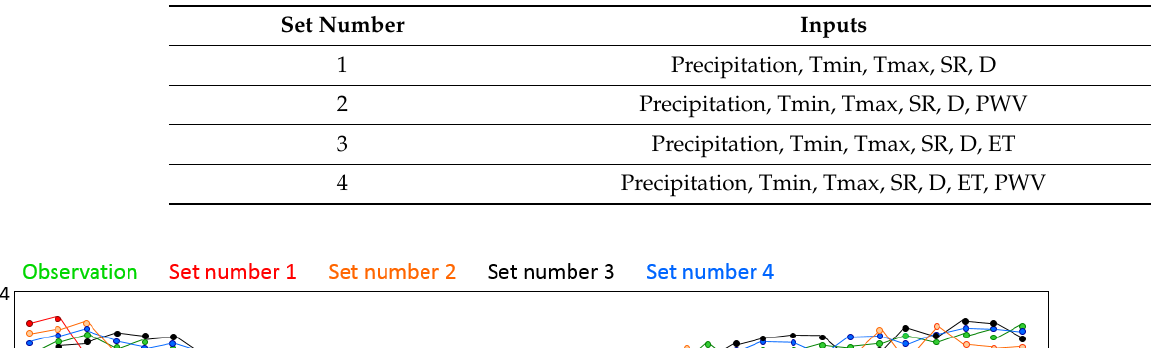
16 of 23 Figure 11. Difference between monthly average of predicted precipitation from 2013 to 2020 and base period . 4.3. Groundwater Level Prediction from 2013 to 2020 In order to check the effect of the use of PWV and ET and the statistical evaluation of all the mentioned processes, the prediction period is considered between 2013 and 2020.